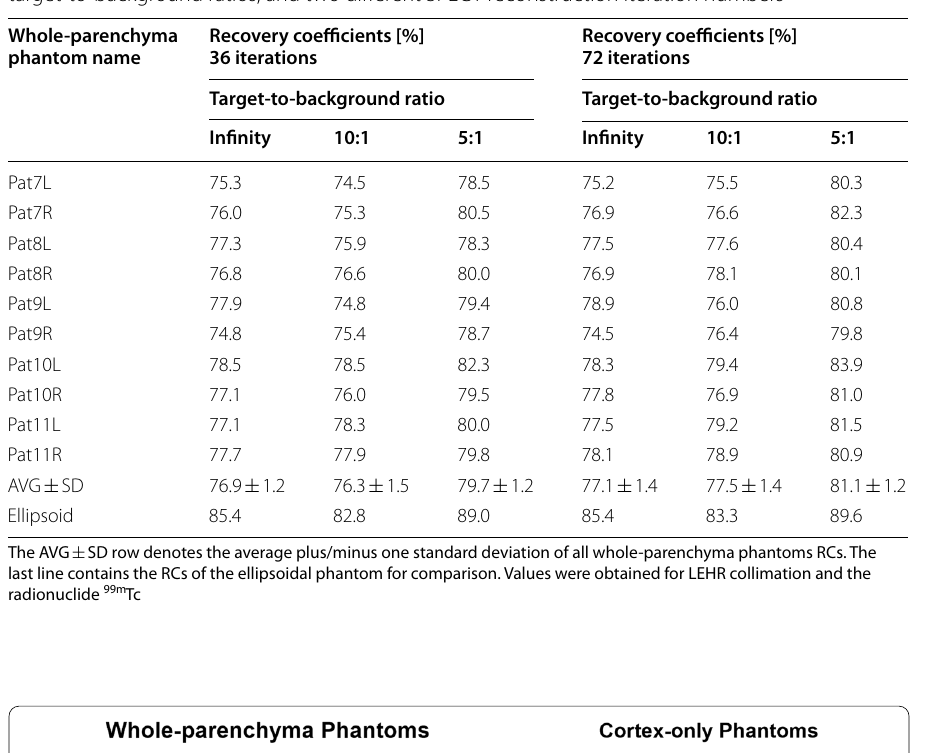
Table 3 Recovery coefficients (RCs) for the whole-parenchyma kidney phantoms, three different target-to-background ratios, and two different SPECT reconstruction iteration numbers